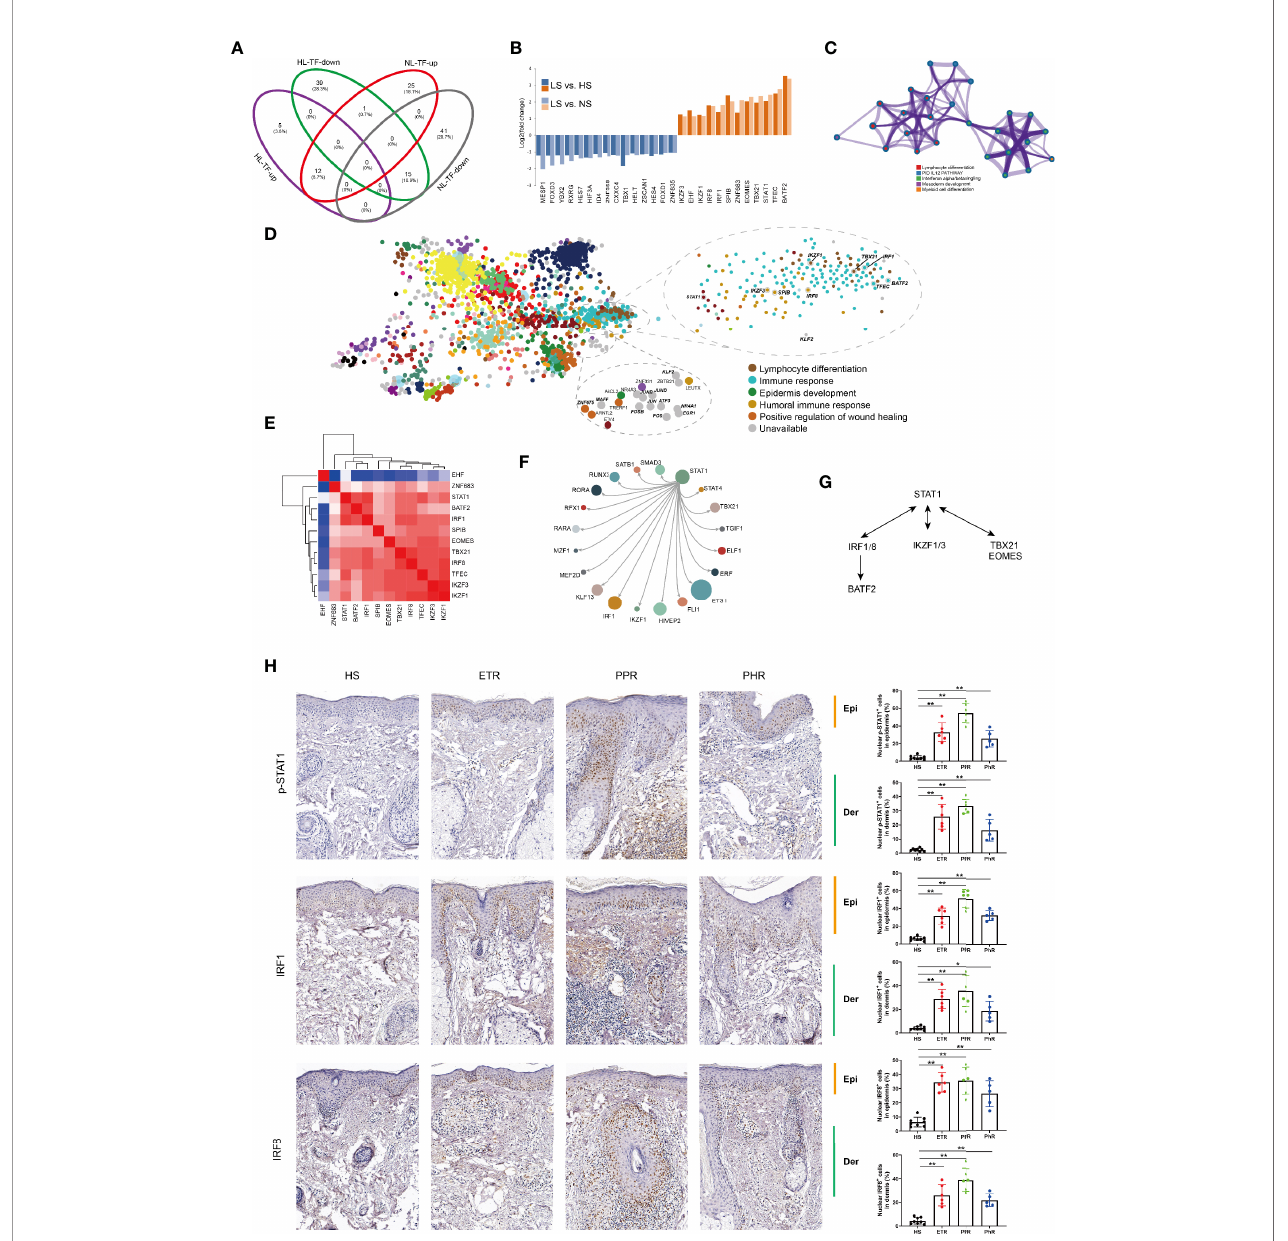
FIGURE 4 | STAT1-mediated in fl ammatory signatures for rosacea lesions. (A) Venn diagram showing the overlap genes between rosacea lesions and normal skin surrounding the auricle and central facial skin. HL: LS vs HS; NL: LS vs NS; up: upregulated genes; down: downregulated genes. LS, lesion skin; HS, healthy skin; NS, matched normal skin; TF, transcription factor. (B) Fold change for the TFs shared between PL vs HN and PL vs PN comparisons. (C) Metascape network analysis of TFs with the GO term of immune responses. (D) Enrichment of TFs generated by the ChEA3 database, and the 9 genes covered are marked, including STAT1, lymphocyte differentiation (IKZF1, TBX21, IRF1), immune response (TFEC, BATF2) and humoral immune response (IKZF3, SPIB, IRF8). (E) Correlation heatmap of upregulated TFs. Red color indicates correlation. (F) The core regulatory circuitry of the TF STAT1 generated by the dbCoRC database (a database of core transcriptional regulatory circuitries), showing the interaction of STAT1 and TBX21, IKZF1and IRF1. (G) . The hypothesized scheme of target genes of STAT1 in different immune cells. (H) Immunohistochemistry staining for validation of p-STAT1, IRF1 and IRF8 expression. HS, healthy skin (n = 8); ETR, erythematotelangiectatic (n = 6); PPR, papulopustular (n = 6); PHR, phymatous (n = 5). Right panel, the quanti fi cation of nuclear localization of p-STAT1, IRF1 and IRF8 in epidermis and dermal in fi ltration of rosacea lesions. Data represent the mean ± SEM. *P < 0.01, **P < 0.01. 1-way ANOVA with Bonferroni ’ s post hoc test was